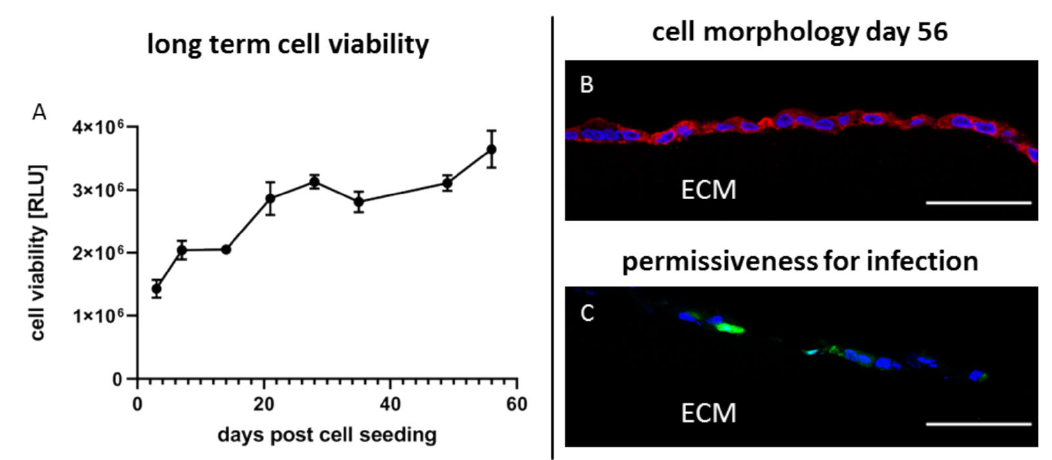
Figure 7. Long-term cultivation of Vero cells on 3D Wellbricks matrices for 8 weeks. Vero E6 cells were cultivated on Wellbricks for 56 days with regular medium exchange every 84 h. Cell viability of uninfected 3D cultures ( n = 2) was determined once a week by ATP measurement with CellTiter-Glo ® (Promega) ( A ). The 8- µ m cryosections of Wellbricks were analysed by fluorescence microscopy. To illustrate the unaltered cell appearance, cryosections were prepared on day 56 and cellular nuclei were counterstained with DAPI (blue) and CF594 (red)-coupled wheat germ agglutinin (WGA) for staining of sialic acid and N-acetylglucosamin on cell membranes ( B ). Vero cells on Wellbricks were cultivated for 55 days and then infected with CPXV. Cryosections taken 24 h p.i. were prepared and counterstained with DAPI (blue). CPXV-infected cells were visualised by monitoring GFP expression (green) of recombinant CPXV. Scale bar = 50 µ m ( C